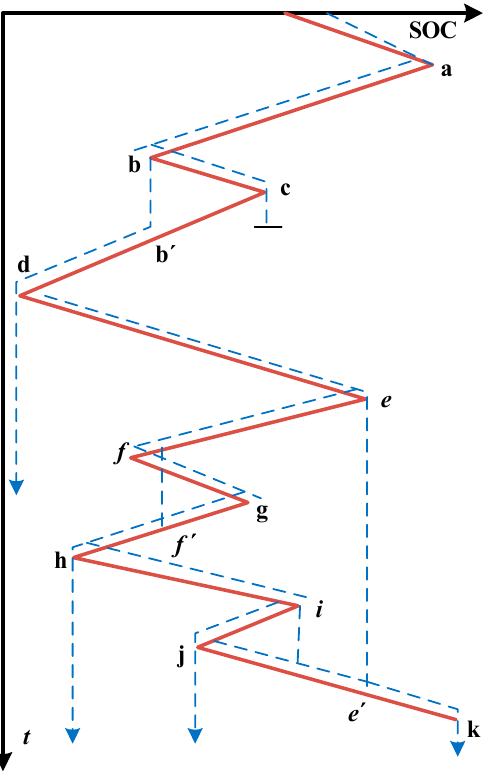
Figure 2. SOC-time process analysis. The main principle of the Rainflow algorithm is to imitate the process of raindrops falling along the eaves. When raindrops fall to the next eaves, a loop will be formed. The SOC time record shown in Figure 2 includes three complete cycles ( b-c-b (cid:48) , f-g-f (cid:48) , and i-j-e (cid:48) ) and three half-cycles ( a-b-d , d-e-e (cid:48) , and e-f-h ). The flow chart of the improved Rainflow algorithm is shown in Figure